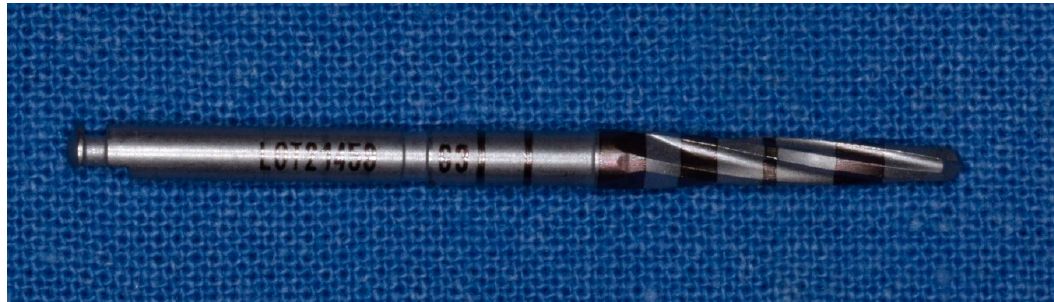
Figure 6. Second cutter with a diameter of 2.0 mm in the method “implant drilling with bone compaction instrumentation technique.”